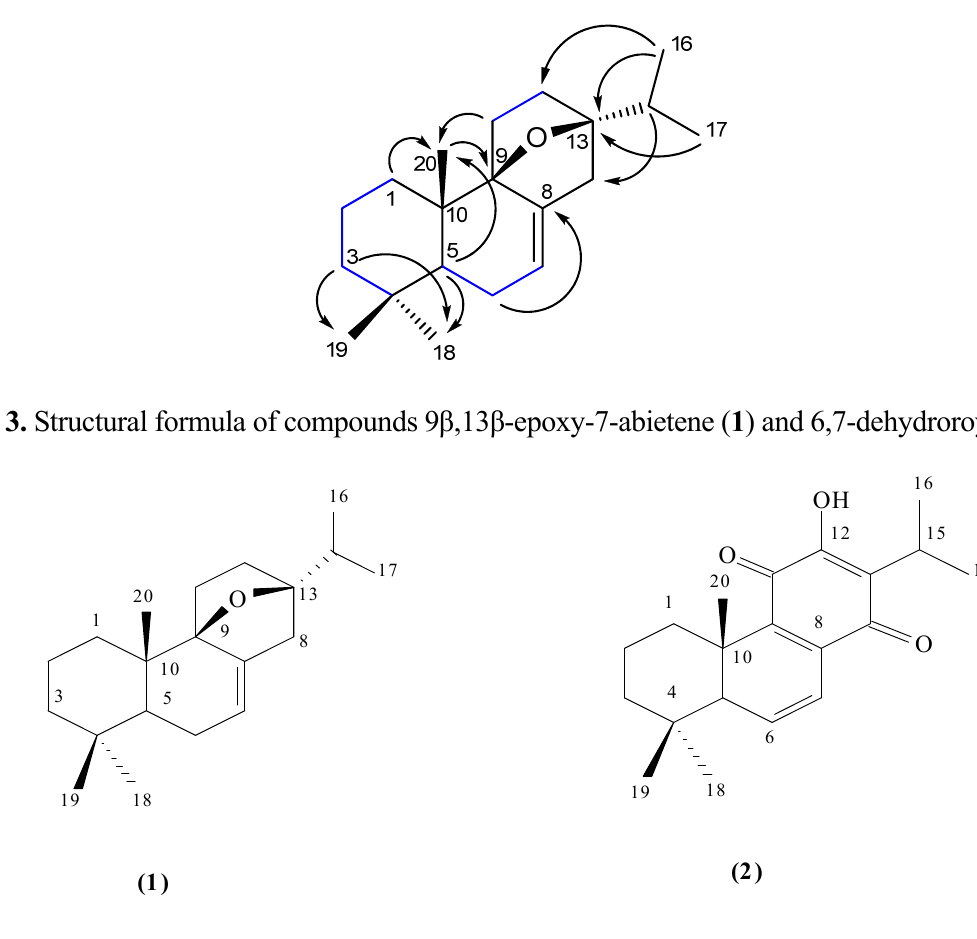
Figure 2. Selected NOESY correlations of 1 .